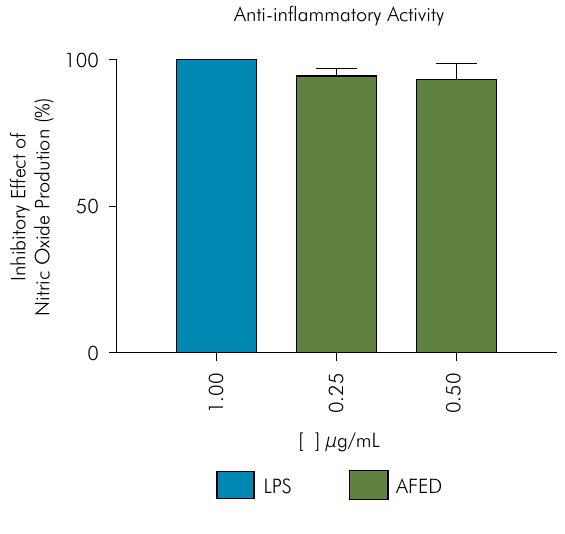
Figure 3. Effect of acetone fraction of Eugenia dysenterica (AFED) on anti-inflammatory activity. RAW 264.7 cells were incubated with AFED (0.25 and 0.5 μ g/mL) and 1 μ g/mL of Escherichia coli lipopolysaccharide for 48 h and the inhibitory effect of nitric oxide production was determined. There was no statistical difference between the groups.